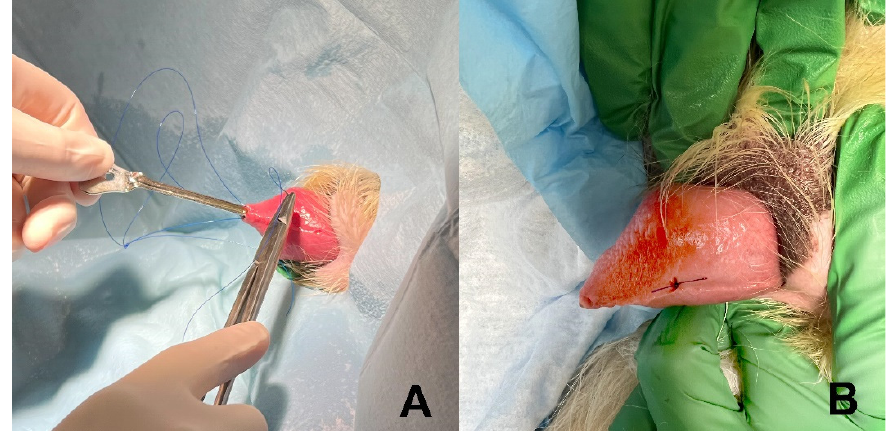
Figure 3. Placing a suture to anchor the temporary stent inside the urethral lumen of a male dog. ( A ) A groove director is inserted in the urethral lumen to assist direction of the needle and suture through the ventral wall of the penis, into the urethral lumen and out the external urethral orifice. ( B ) Completed suture after it was attached to the anchoring loop on the temporary stent, passed back into the urethral lumen and out of the ventral wall of the penis, and tied.